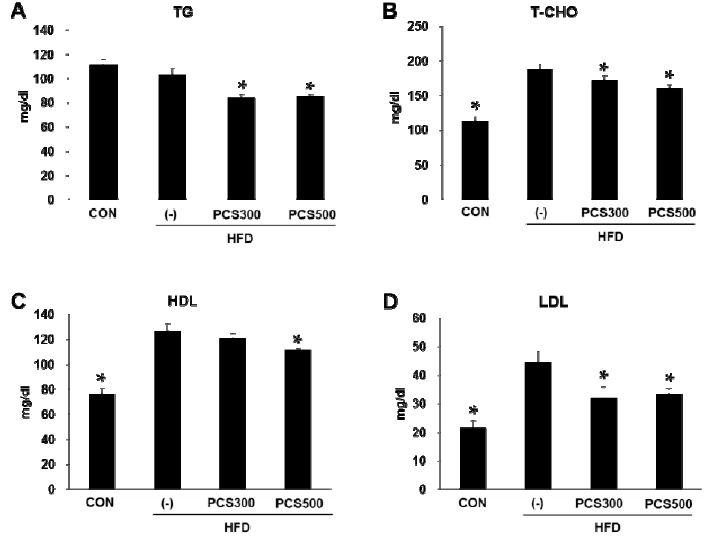
Figure 3. Effect of PCS extract on serum TG and cholesterol levels. Mice were fed with regular chow diet (CON) or HFD for 12 weeks. HFD-fed were treated with vehicle ( − ) or PCS extract (300 or 500 mg/kg/day) from the first day of HFD feeding ( n = 7–10/group). ( A ) Triglyceride levels (TG); ( B ) Total cholesterol levels (T-CHO); ( C ) HDL-cholesterol levels; and ( D ) LDL-cholesterol levels in sera were measured after 12 weeks after PCS extract treatment. * p < 0.05 vs. vehicle-treated HFD-fed mice.